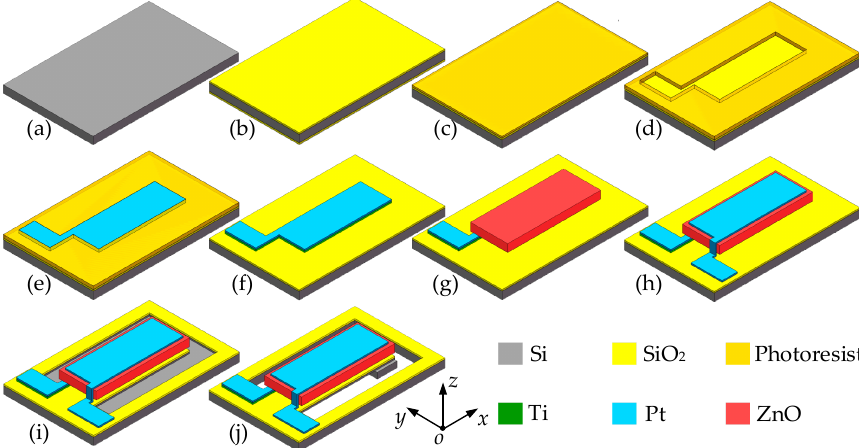
Figure 5. Fabrication process of the piezoelectric beam: ( a ) Si wafer; ( b ) growing SiO 2 ; ( c ) coating photoresist; ( d ) patterning photoresist; ( e ) depositing Pt / Ti; ( f ) removing photoresist; ( g ) depositing ZnO; ( h ) depositing Pt; ( i ) etching on the top side; ( j ) releasing cantilever beam.